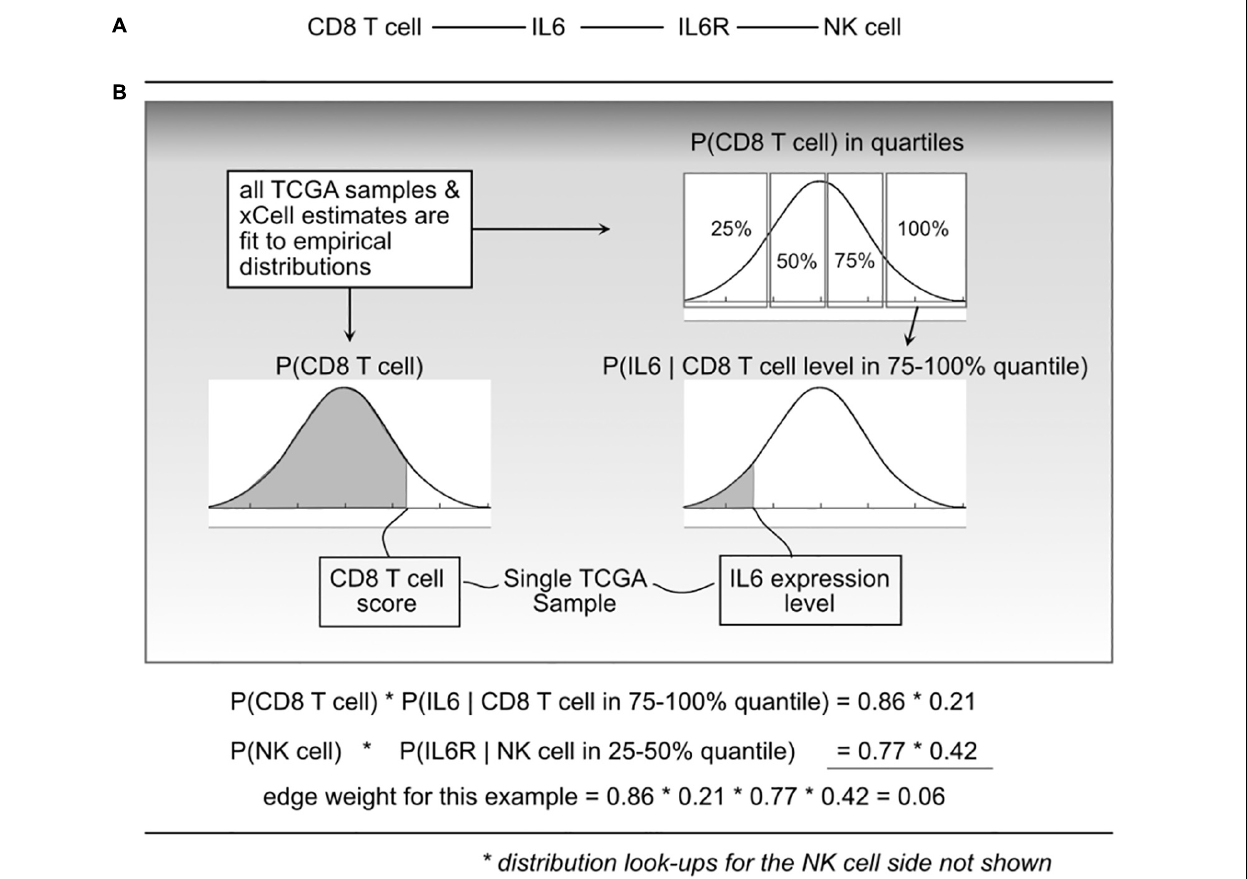
FIGURE 2 | Illustration of the probabilistic model and edge weight computations. (A) For a given cell-cell communication edge, (B) per patient values are used to “look up” probabilities from the distributions learned from all The Cancer Genome Atlas (TCGA) data. Those probabilities are then used to compute an edge